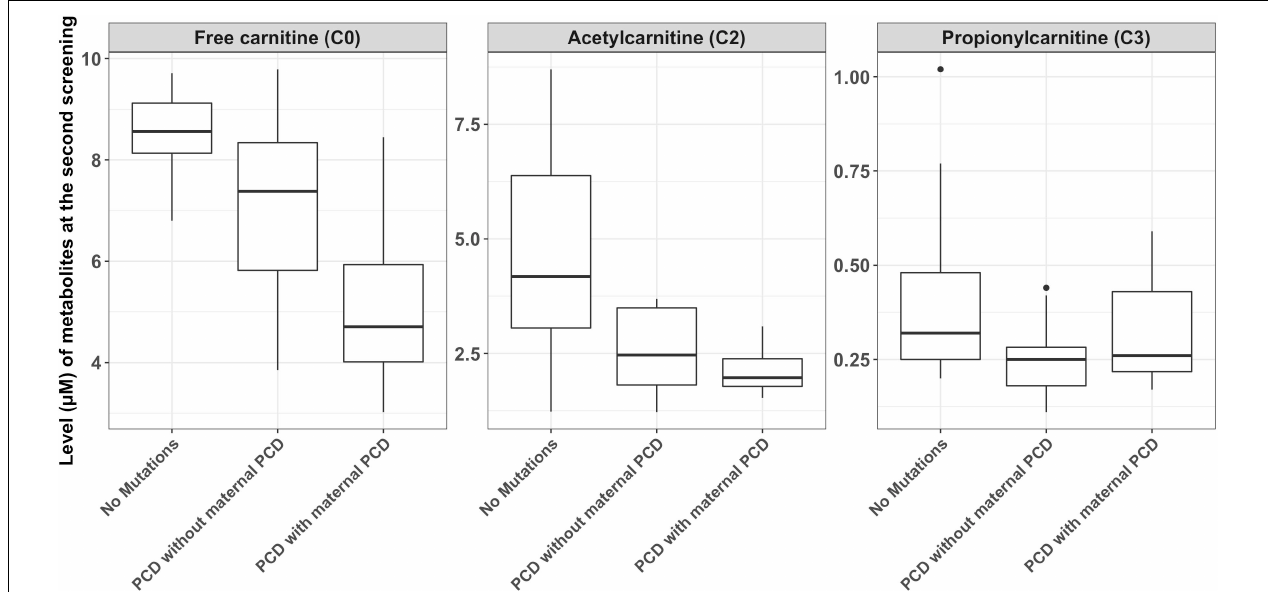
FIGURE 2 | The comparisons of metabolite measurements between newborns with primary carnitine deficiency (PCD), newborns with no mutations in SLC22A5 and newborns with maternal PCD.